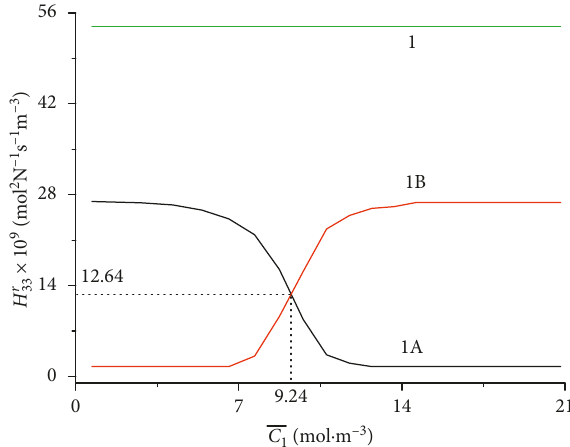
Figure 6: The graphic illustration of the dependence H r f ( C 1 , Figure 8: The graphic illustration of the dependence 23 (cid:31) 3 ) ( r C A, B) for the glucose in aqueous ethanol 3 ) ( r H r f ( C 1 , C 2 37.71mol m A , B ) for the glucose in aqueous 2 (cid:31) 37.71mol · m (cid:31) 33 (cid:31) (cid:31) · (cid:31) solution in conditions of concentration polarization for configu- − ethanol solution in conditions of concentration polarization for − 3 ), curve 1A) and B ration A ( H A f ( C 1 , C 2 37.71mol m 3 ), curve 1A) and B configuration A ( H A f ( C 1 , C 2 37.71mol m 23 (cid:31) (cid:31) · 33 (cid:31) (cid:31) · 3 ), curve 1B), of the membrane ( H B f ( C 1 , C 2 37.71mol m 3 ), curve 1B), of the membrane − f ( C 1 , C 2 37.71mol m ( H B 23 (cid:31) (cid:31) · − 33 (cid:31) (cid:31) · f ( C 1 , C 2 const.) in system. Line 1 illustrates the dependence H 23 − system. Line 1 illustrates the dependence H 23 f ( C 1 , C 2 const.) in (cid:31) (cid:31) − (cid:31) (cid:31) conditions of homogeneity of solutions. conditions of homogeneity of